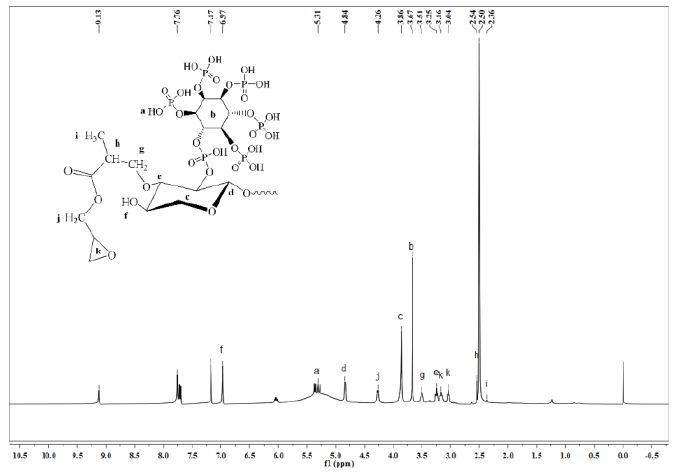
Figure 8. 1 H NMR spectrum of GMA